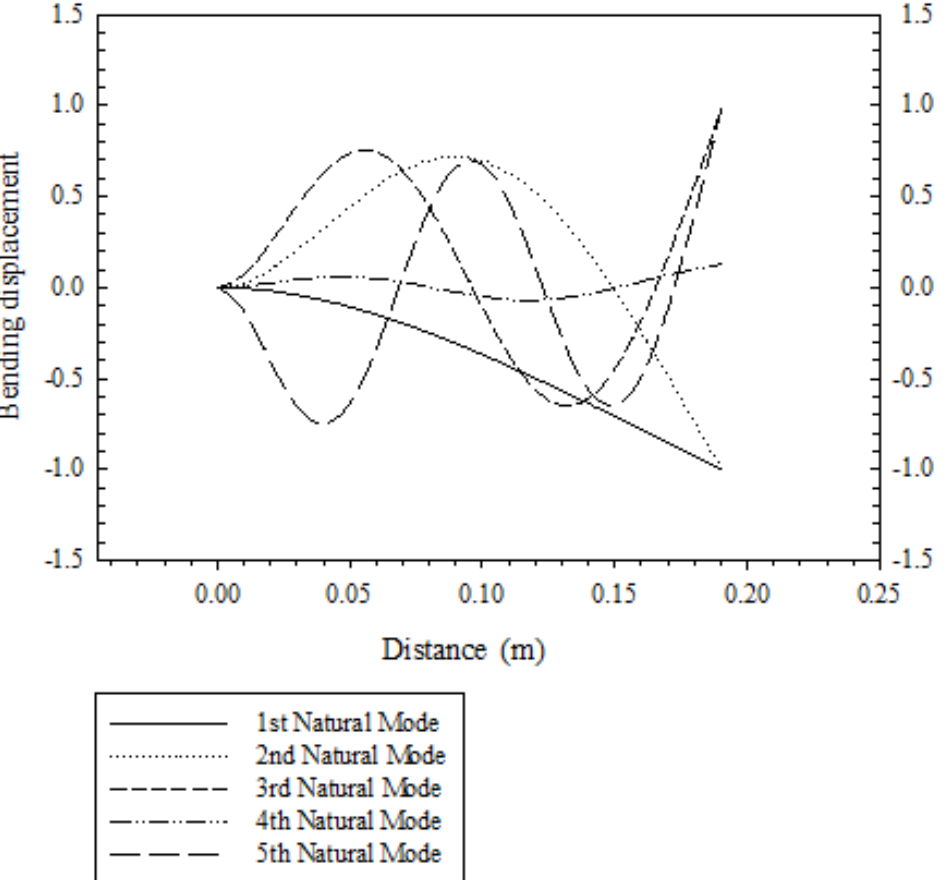
Figure 7. The bending components for the first five natural mode shapes, obtained using the DFE method (bending displacement is normalized).